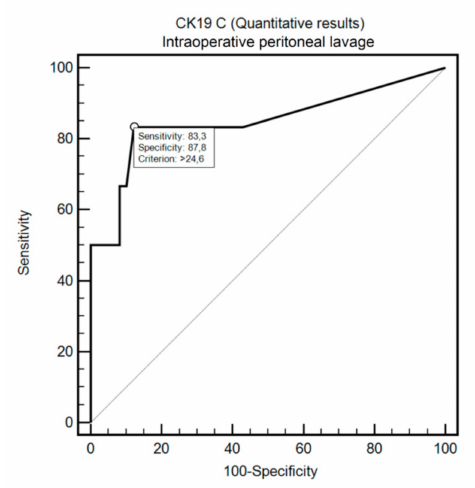
Figure 3. Diagnostic usefulness of CK19 concentration in di ff erentiating positive and negative cytology in the intraoperative peritoneal